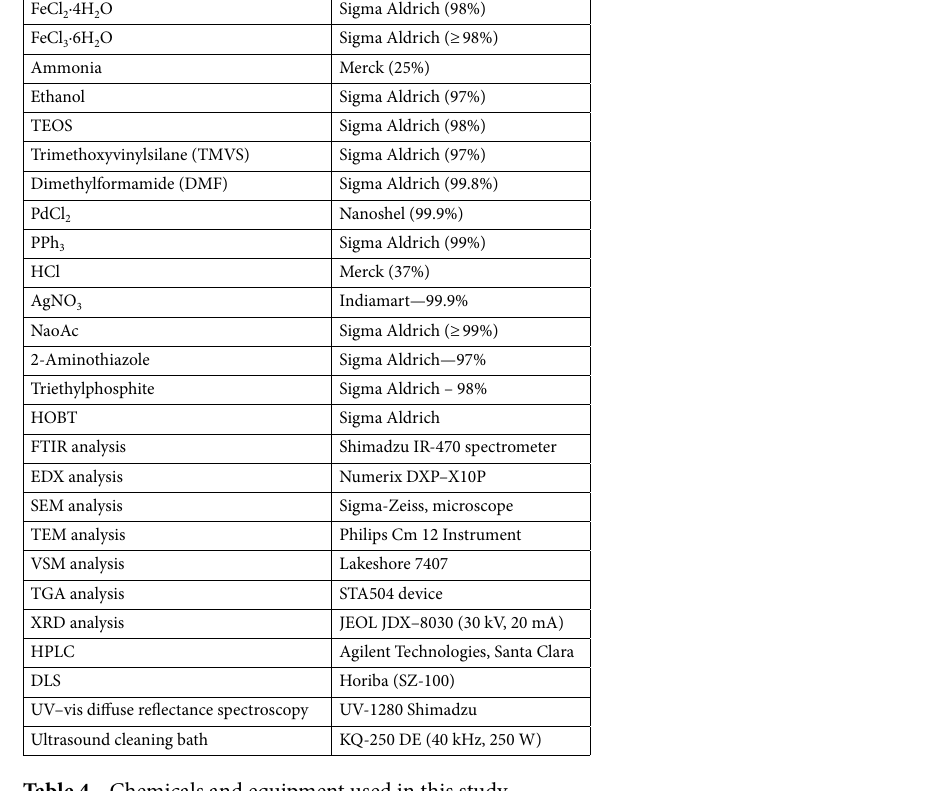
Table 4. Chemicals and equipment used in this